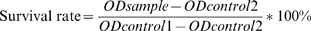
Inhibition ability of receptor variants (vWA domain) for protecting J774A-1 cells from PA intoxication.The survival rate is calculated using the equation:Control 1 is cells treated without either PA or receptors (mutants) and control 2 is cells treated with PA but without receptors. (A) The protective ability (IC50) of TEM8 variants that replace the original residue with Ala or contrary charged residue at the conserved sites in the binding interface between TEM8 and CMG2. (B) The protective ability (IC50) of TEM8 variants that replace the original residue with the corresponding residue in CMG2 at the non-conserved sites. Data points and error bar represent the mean ± SEM values for three independent experiments in (A) and (B). (C) Survive curves show the negative Log value of the IC50 by TEM8 variants/receptors, based on results showed by (A). In the same way, (D) is the corresponding curves of (B). Data points and error bar represent the mean ± SEM values for one representative experiment with duplicates in (C) and (D).